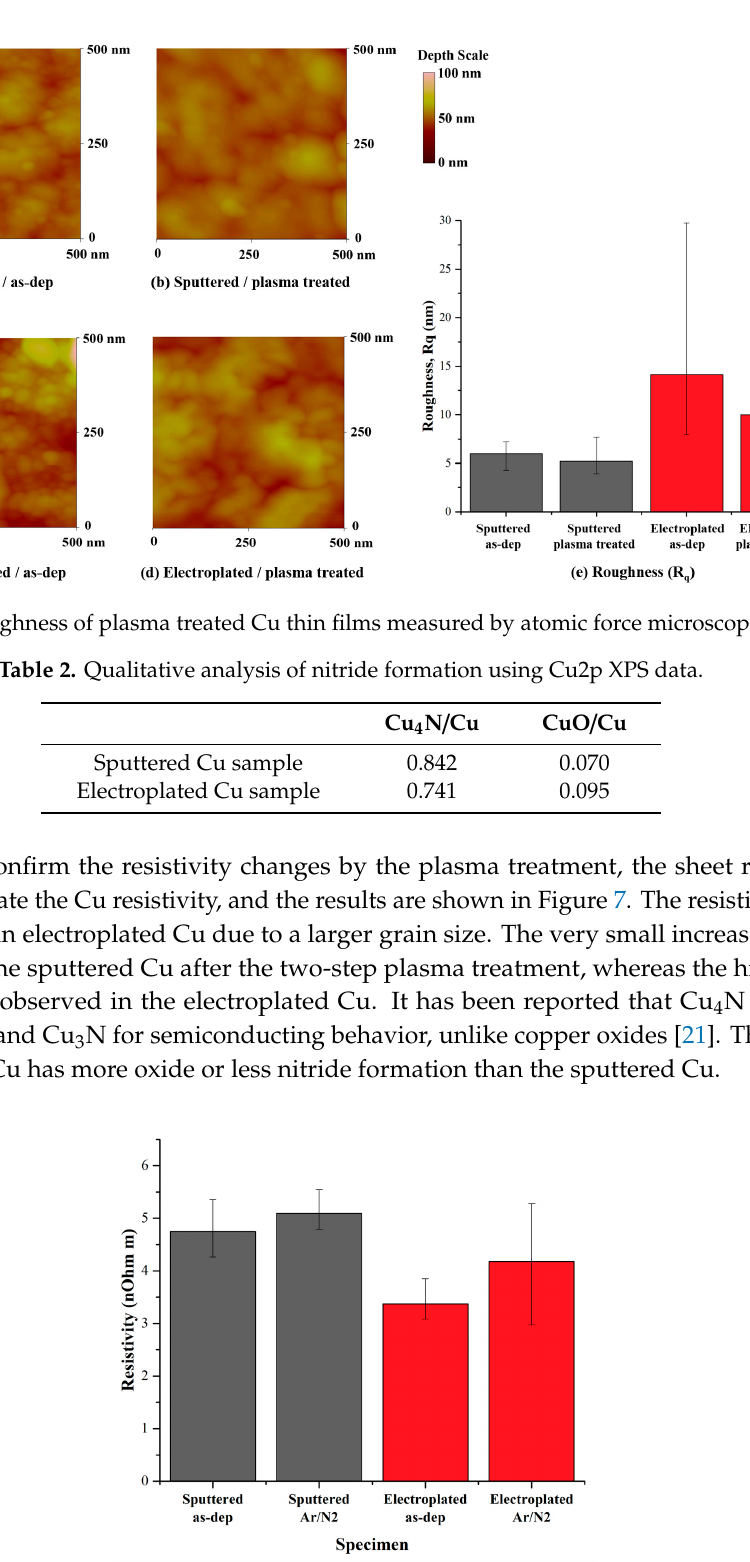
Figure 5. XPS analysis: ( a ) Cu2p, ( b ) O1s, ( c ) N1s.